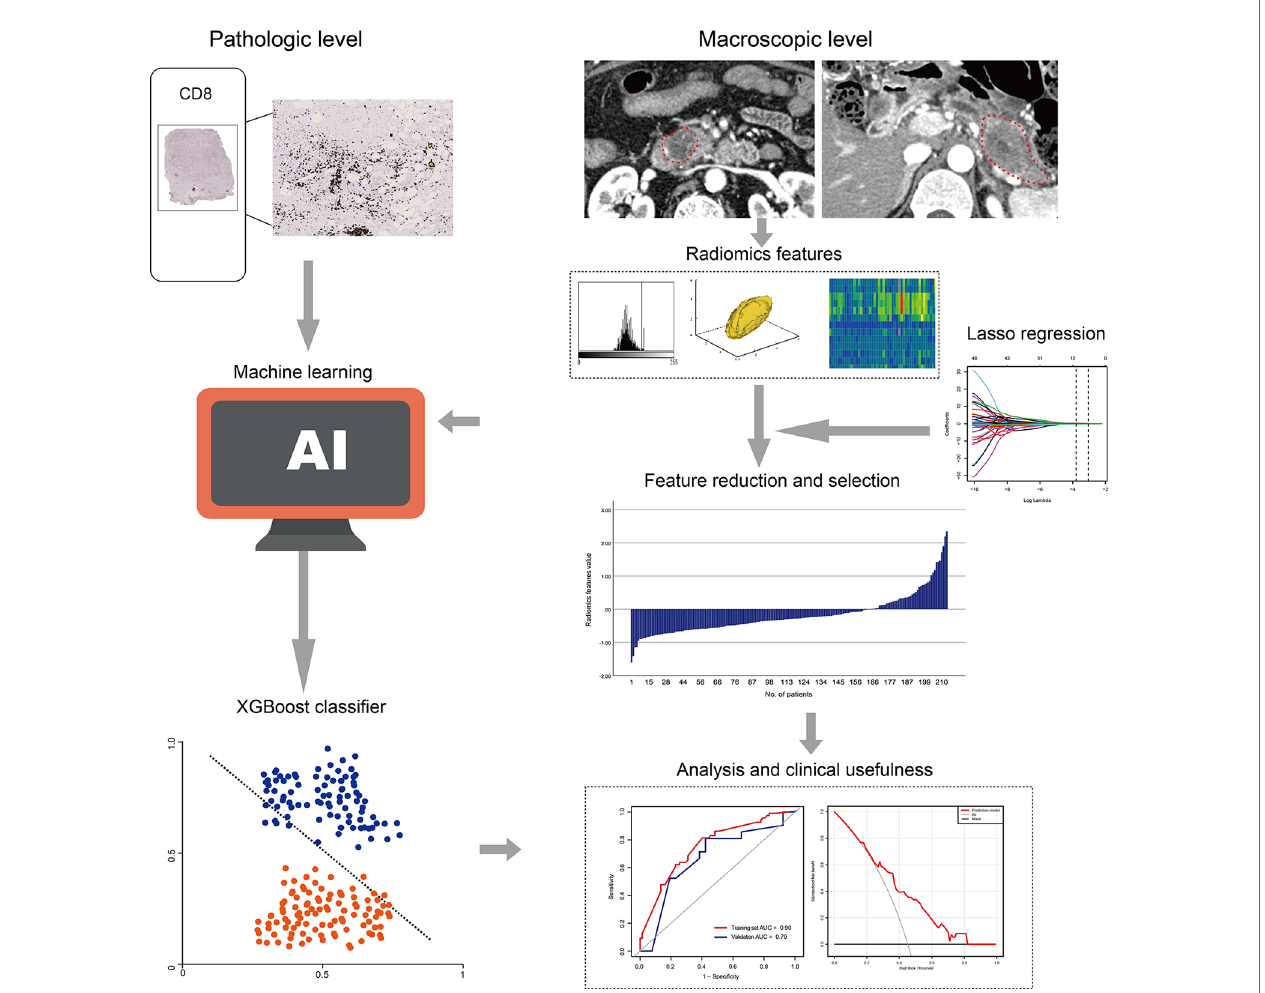
FIGURE 2 | Radiomics work fl